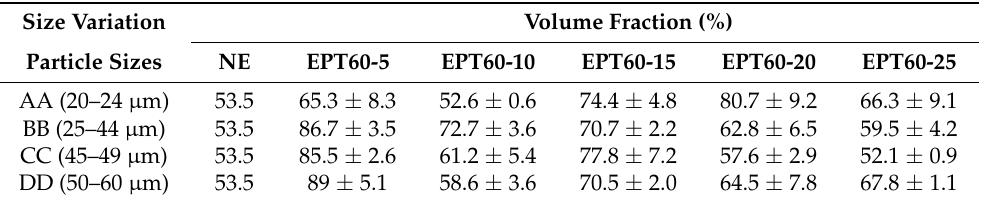
Table 4. Flexural strength of SFC filled with HGM-epoxy resin (MPa).